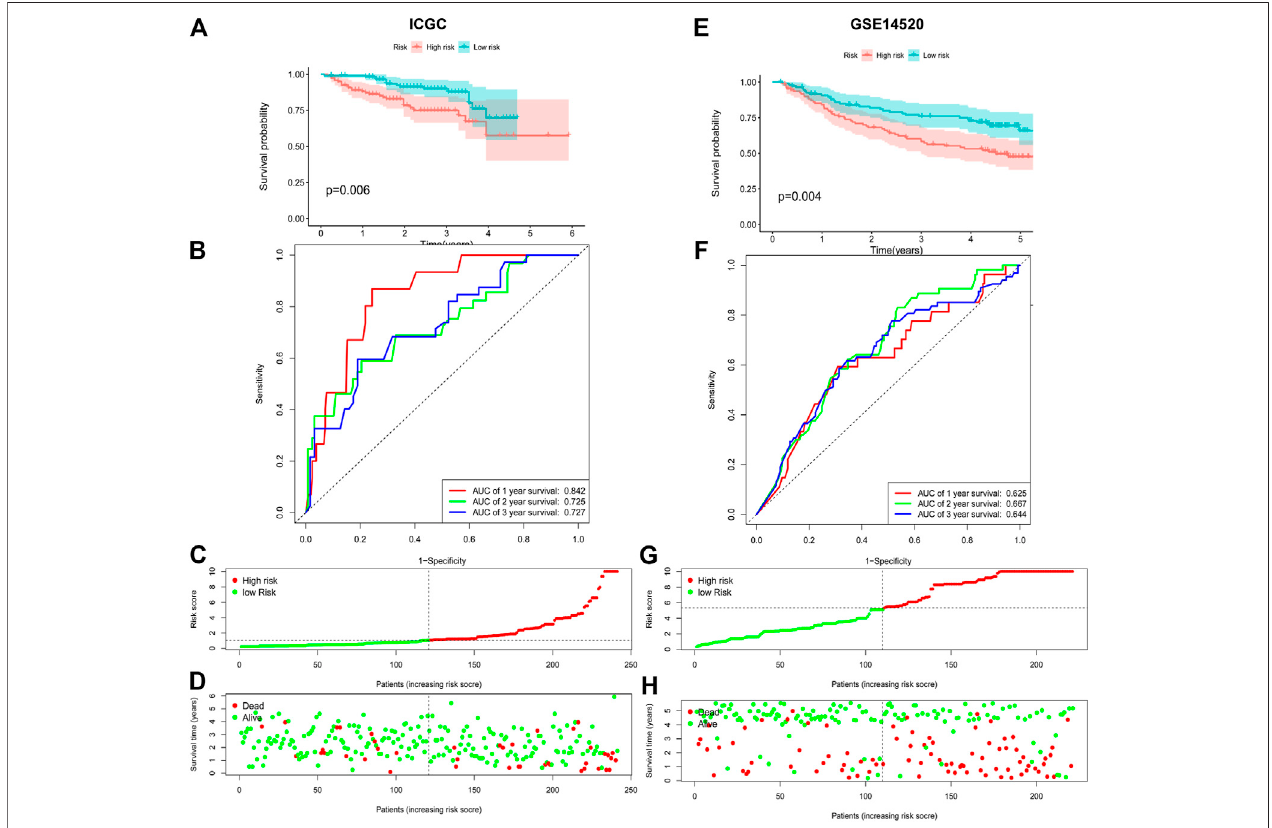
FIGURE2| Evaluating theef fi ciencies ofthe risksignature intheICGC and GSE14520 datasets. (A,E) ,Kaplan-Meier survivalcurves showed theprognosticvalue of the risk signature in ICGC data set (A) . low-risk group, n (cid:1) 120; high-risk group, n (cid:1) 121; p < 0.05) and GSE14520 database (E) . low-risk group, n (cid:1) 111; high-risk group, n (cid:1) 110; p < 0.001). (B, F) , ROC curves evaluated the ef fi ciency of the risk signature for predicting 1-, 2- and 3-y survival in ICGC data set (B) and GSE14520 database (F) . (C,G) ,TheriskscoresdistributionintheICGCdataset (C) andGSE14520 database (G) . (D,H) ,Thepatients ‘ survivalstatus intheICGC dataset (D) and GSE14520 database (H)